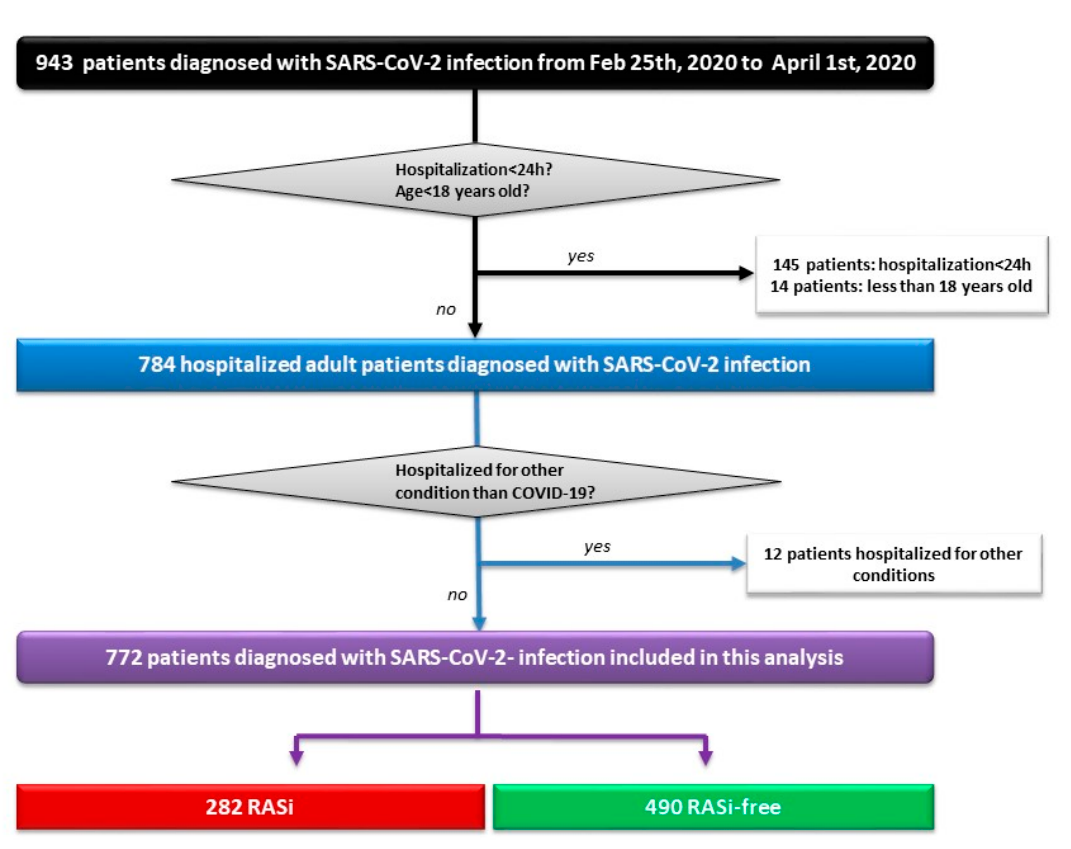
Figure 1. Study flowchart showing patient selection. h: Hours; Feb: February; RAS: Renin–angiotensin system; RASi: Renin–angiotensin system inhibitor(s).